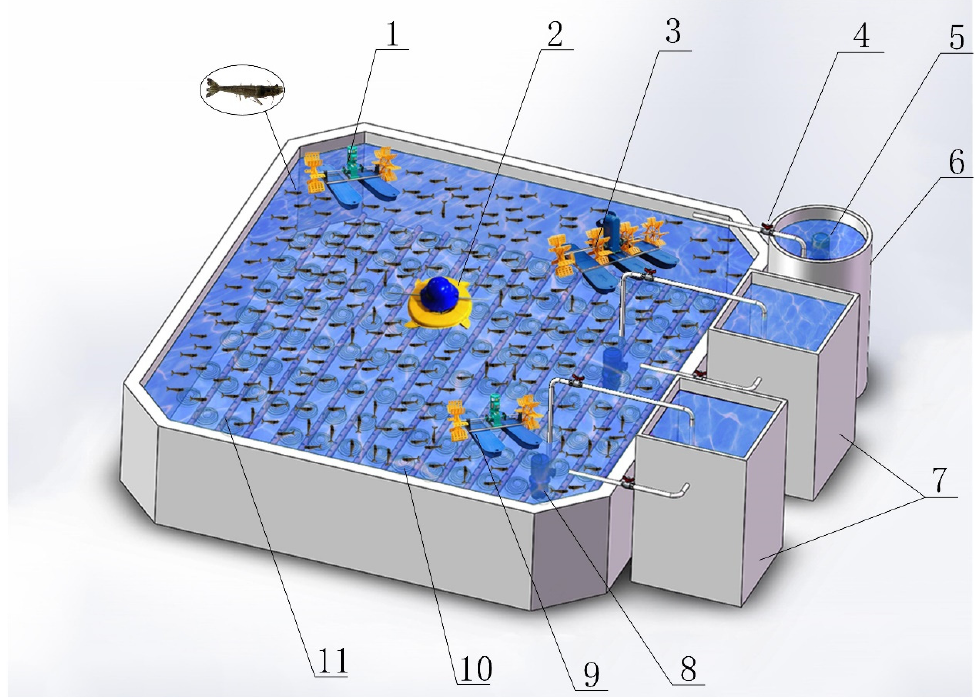
Figure 1. Three-dimensional schematic diagram of large-scale biofloc shrimp culture facility system. 1. Decelerating water wheel aerator. 2. Wave aerator. 3. High-speed water wheel aerator. 4. Globe valve. 5. Water pump. 6. Polyethylene barrel. 7. Polyvinylchlorid tank. 8. Water pump. 9. Decelerating water wheel aerator. 10. Aeration tray. 11. Polyvinylchlorid aeration tray.